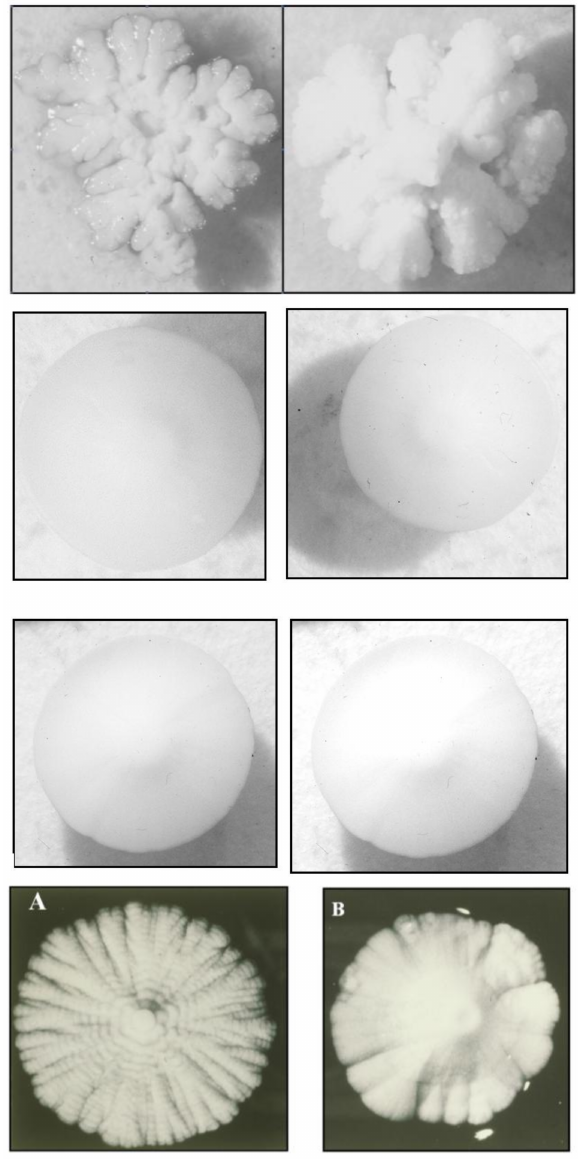
Figure 13. Giant colony morphologies of brewer’s yeast strains ( A , B ) exhibit the co-flocculation phenotype